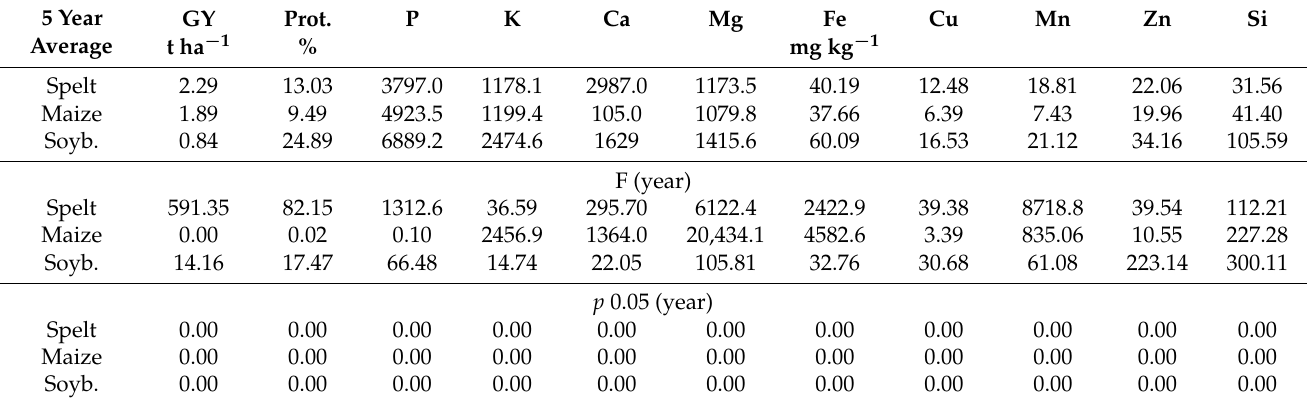
Table 4. Analysis of variance for the variation of grain yield (GY) and protein content in grain, as well as the concentration of P, K, Ca, Mg, Fe, Cu Mn, Zn, and Si in grain of organically grown maize, spelt, and